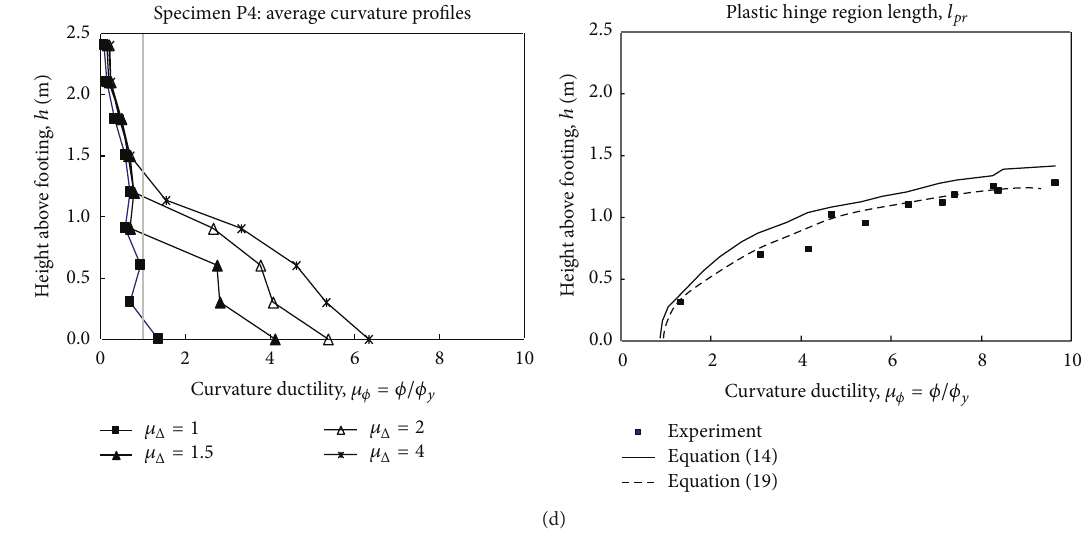
Figure 8: Experimental and theoretical spread of plasticity, 𝑙 𝑝𝑟 . Table 4: Mean differences and coefficients of variation for analytical and experimental values of 𝑙 𝑝𝑟 and 𝑙 𝑝 .